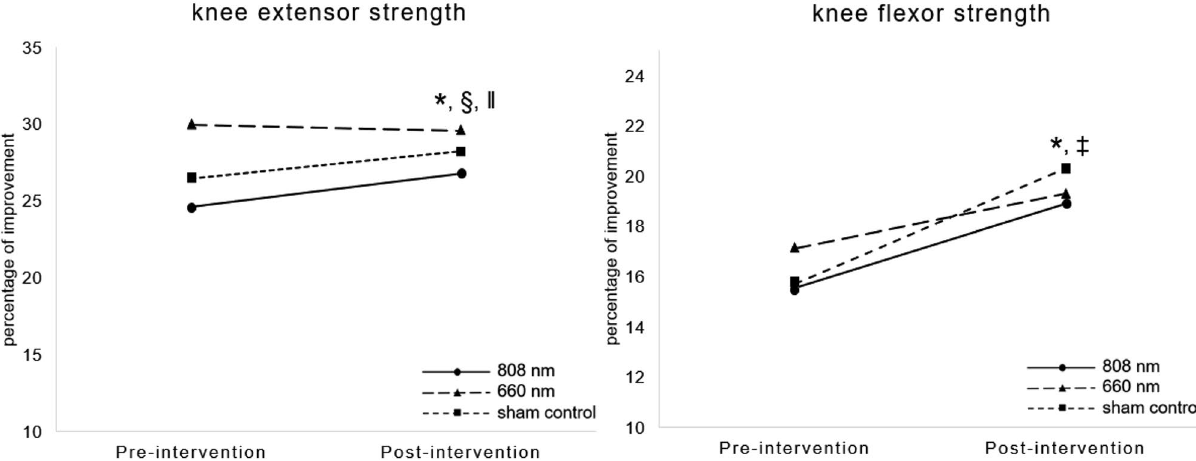
Figure 3. Comparison of knee muscle strength between pre-and post-intervention among the 808 nm, 660 nm, and the sham control groups. * indicates a statistically significant difference between pre-and post-intervention in the 808 nm group, ‡ indicates a statistically significant difference between the pre-and post-intervention in the sham control, § indicates a statistically significant difference between the 808 nm and 606 nm group, and ‖ indicates a statistically significant difference between the 808 nm and the sham control